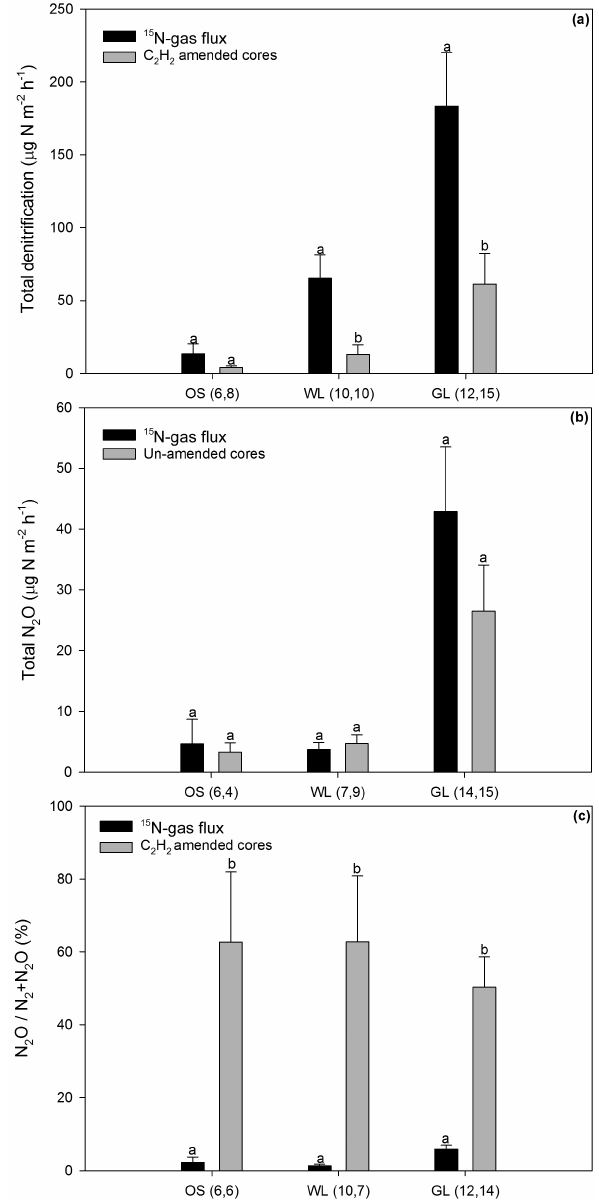
Figure 5. (a) Mean total denitrification measured with the 15 N gas-flux method and the AIT, (b) mean bulk N 2 O emission mea- sured in the static chambers of the 15 N gas-flux method and in un- amended intact soil cores, and (c) the denitrification product ratio N 2 O / (N 2 + N 2 O) with the 15 N gas-flux method and the AIT in the three land use types (OS: organic soils; WL: woodland; and GL: grassland). Same lower-case letters indicate no significant dif- ferences ( p >0.05) between measurement methods according to an independent samples t test. The sample size ( n ) is given in paren- theses for each land use type and each method on the x axis. Error bars represent standard